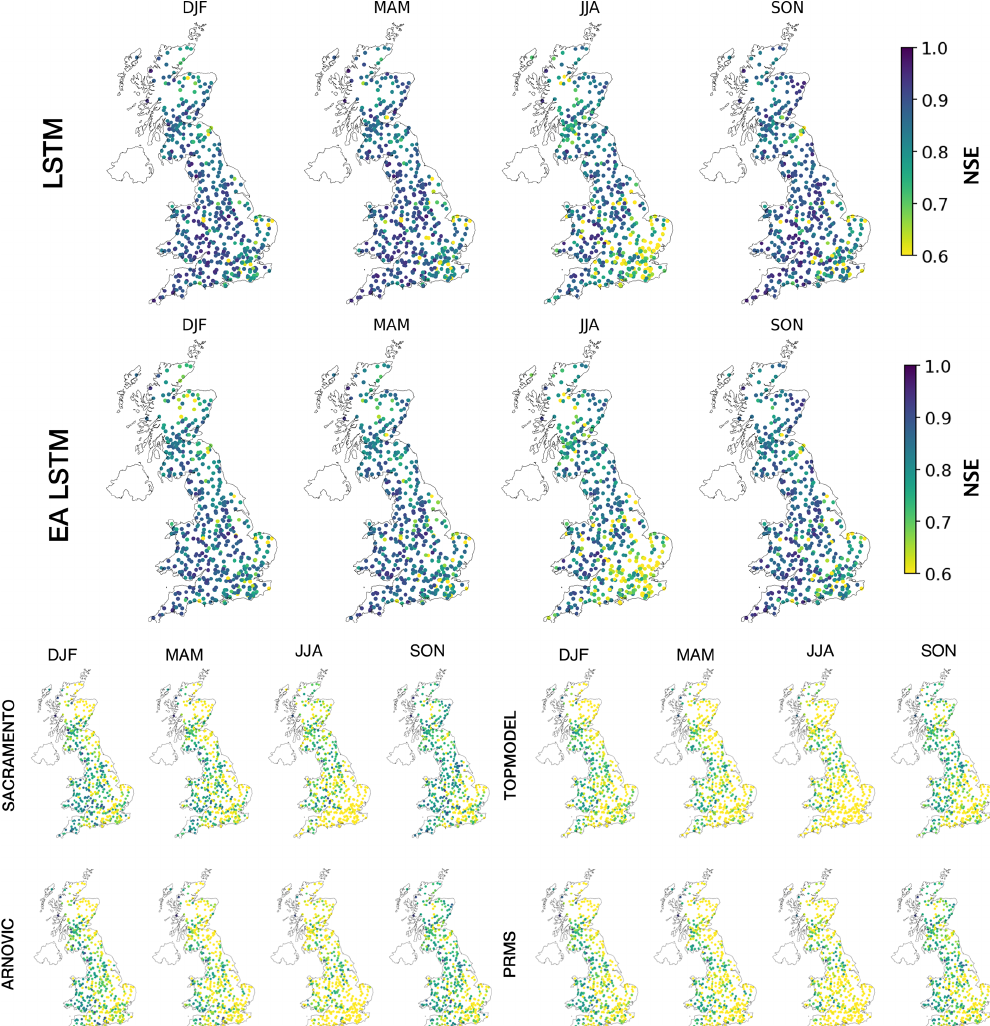
Figure 2. Seasonal NSE patterns for the two LSTM-based models (above) and the conceptual models (below). Each station in the evaluation data is shown as a point. The colour of the point reflects the NSE score. Brighter colours reflect lower NSE values, currently capped at a minimum of 0.7